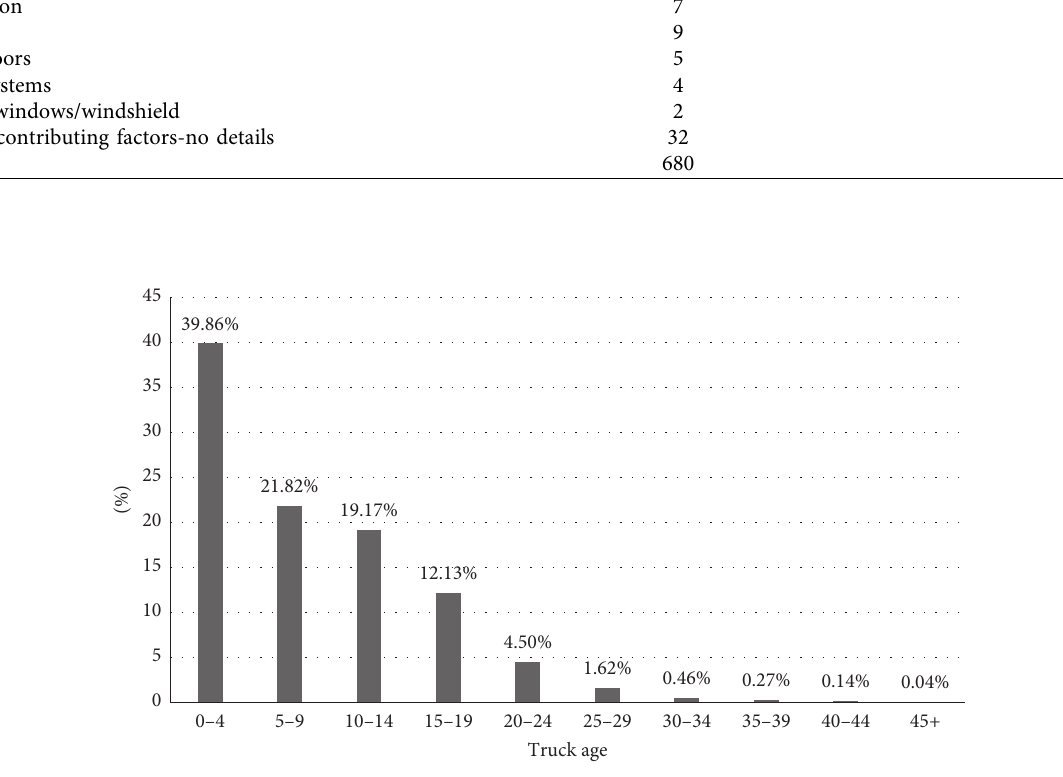
Figure 1: Distribution of truck age.